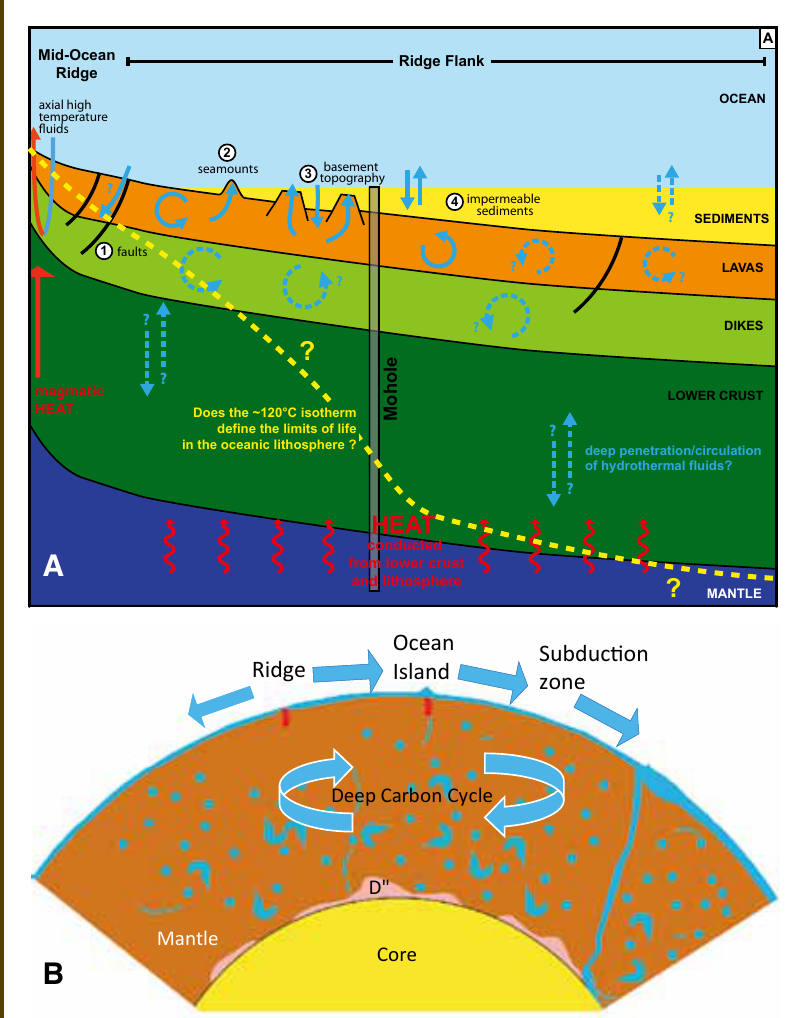
Figure 2. [A] Schematic illustration of the creation and evolution of oceanic crust near the ridge axis. After Ildefonse et al. (2010). [B] How the plate tectonics affects the physics and chemistry of mantle heterogeneities including carbon cycles are largely unknown. After Helffrich and Wood (2001).